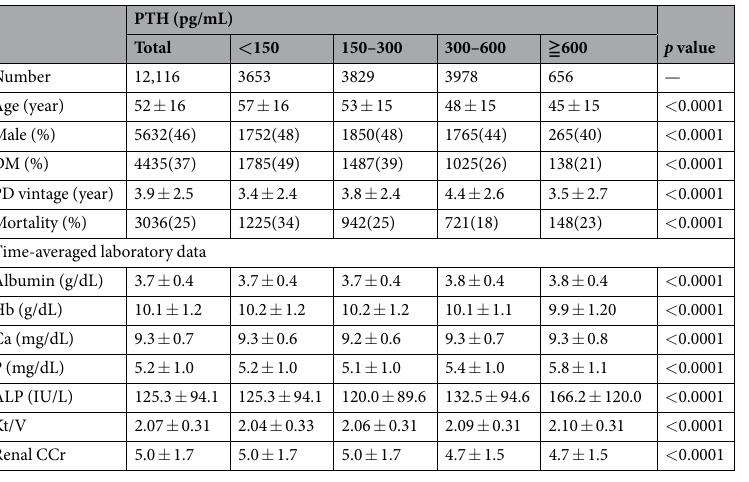
Table 2. Demographic characteristics and time-averaged laboratory data of the Included PD patients. PD, peritoneal dialysis; DM, diabetes mellitus; Hb, Hemoglobin; Ca, serum total calicium; P, serum phosphorus; PTH, parathyroid hormone; ALP, total alkaline phosphatase; Renal CCr, renal creatinine clearance. † PD vintage of each patient was calculated from the start of 2005 to termination of PD or the end of 2012. ‡ Weekl Kt/V, including renal